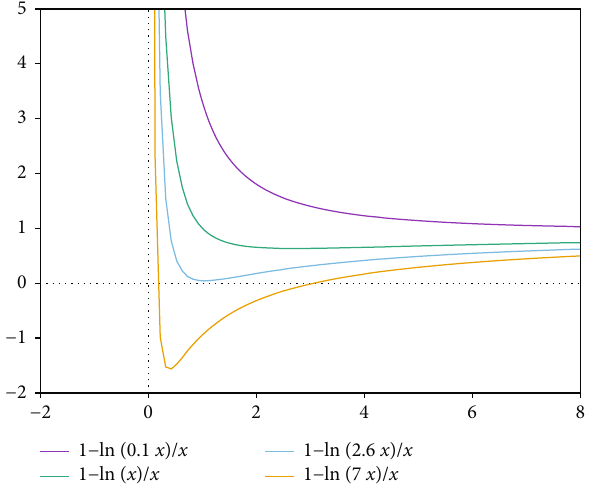
Figure 1: The graph of ζ ð x Þ = 1 − ð ln ax / x Þ for a = 0 : 1,1, 2 : 6,7